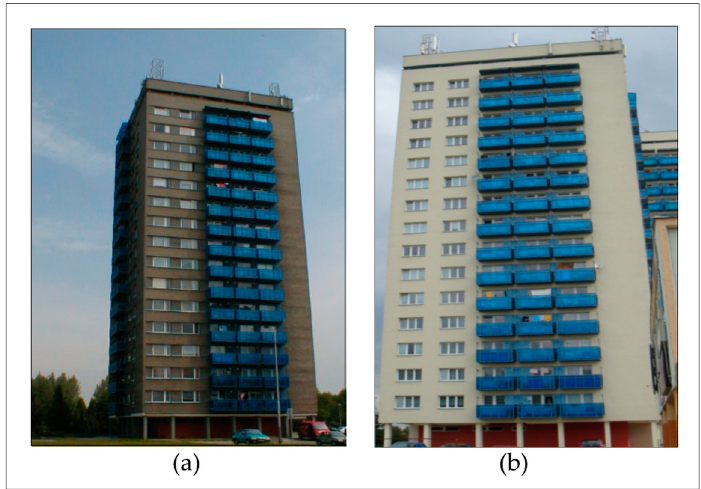
Figure 3. Renovation of prefabricated residential housing buildings using ETICS: ( a ) Type VM-OS tower prefab panel construction system prior to applying ETICS; ( b ) type VM-OS tower prefab panel construction system after applying ETICS (Photo source: Author's archive [29,30]).